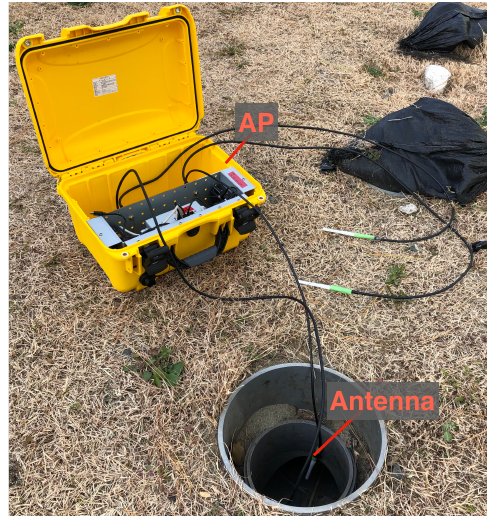
Figure 3. An access point installed in a hole.